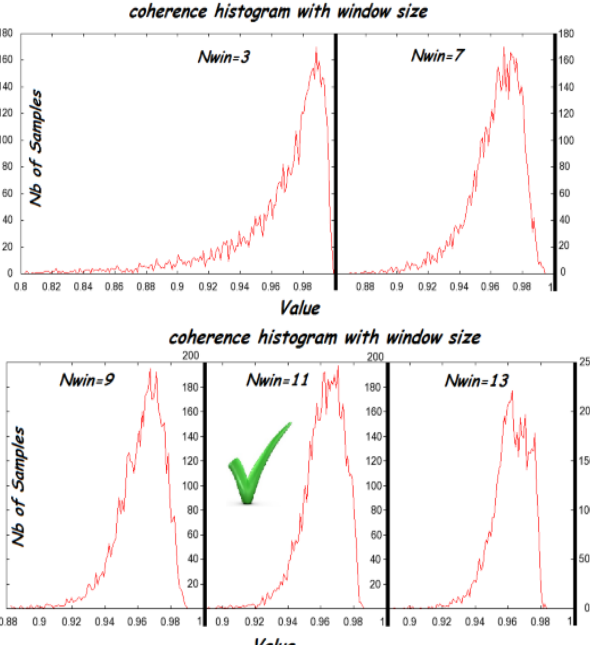
Figure 2. Coherence histograms obtained over the plot for different window sizes (N =3, 7, 9, 11,